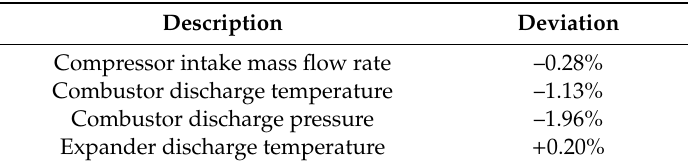
Table 1. Percent deviations between reference data and TGSim Plus ™ results at Full-Speed Full-Load (FSFL). Note that temperature deviations are based on a normalisation on temperature values in